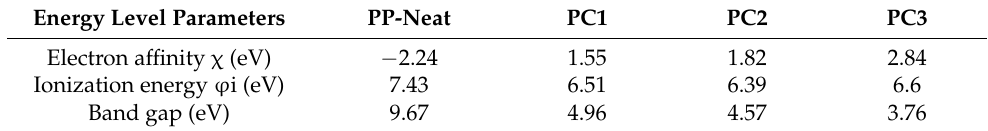
Table 3. Energy level parameters of